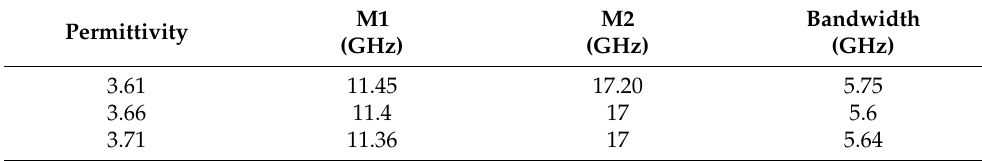
Table 3. Simulation of antenna bandwidth at high and low temperatures.